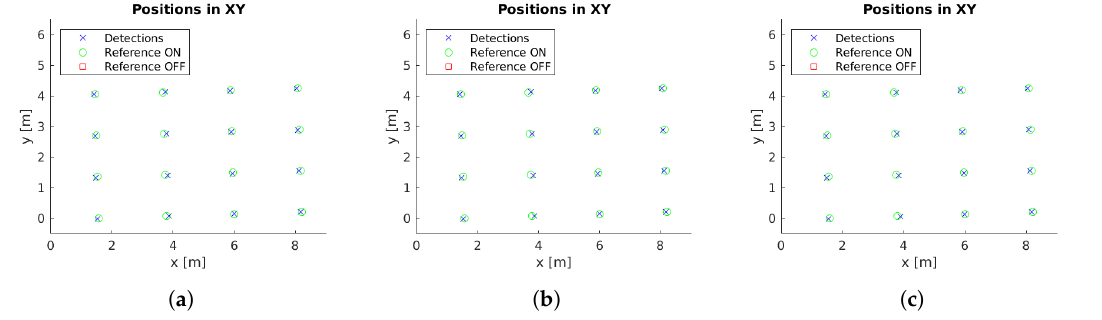
Figure 6. Cluster centers and reference values for case study 1. ( a ) Unconstrained system [31], ( b ) system with reprojection error filtering, and ( c ) system with filtering and orientation alignment..